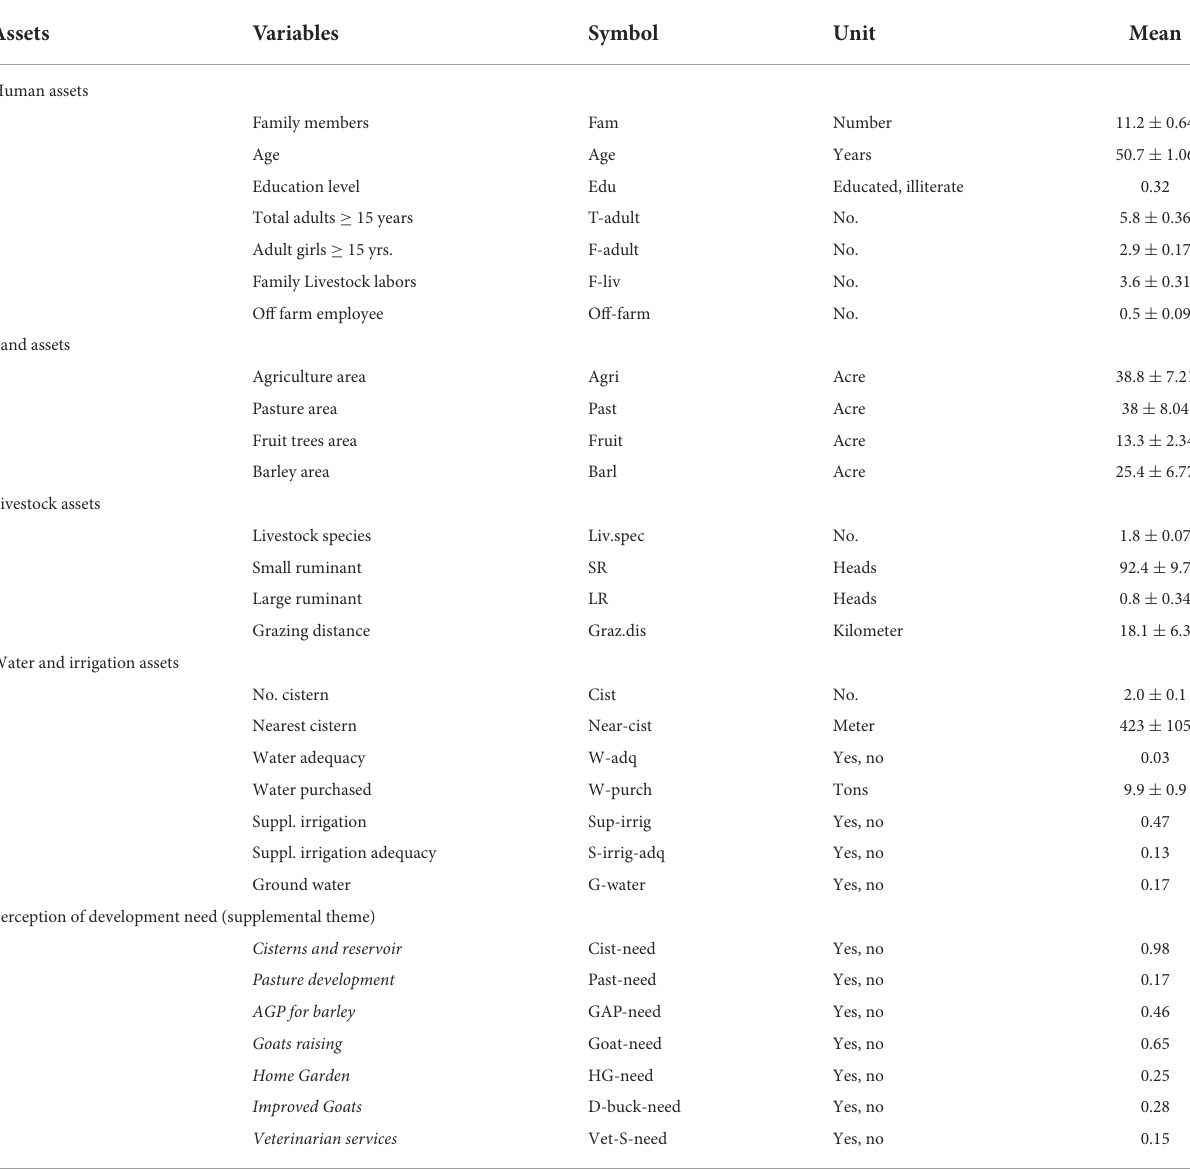
TABLE 3 Performance and diversity of householders with different assets and